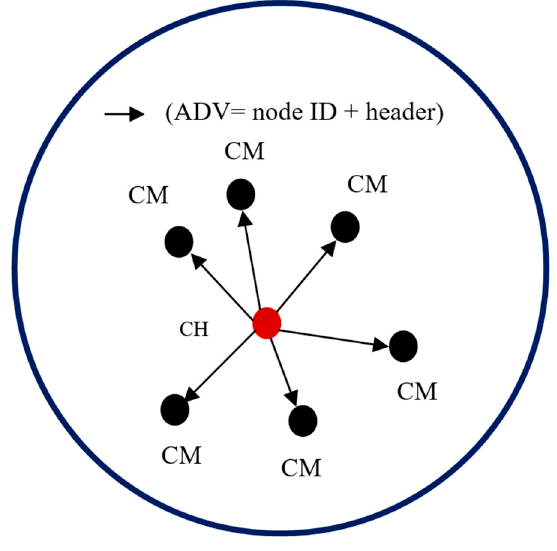
Figure 7. CH advertising to the CMs.